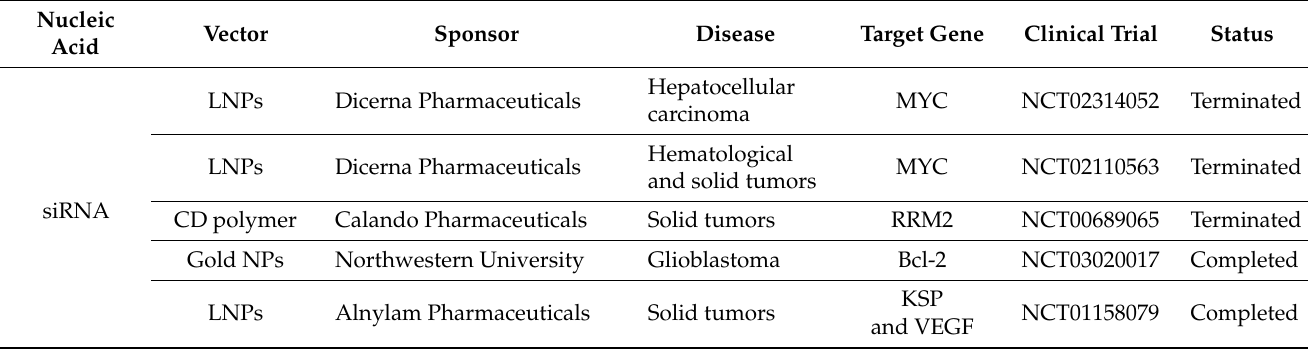
Table 5. Non-viral vectors that are in clinical trials for cancer